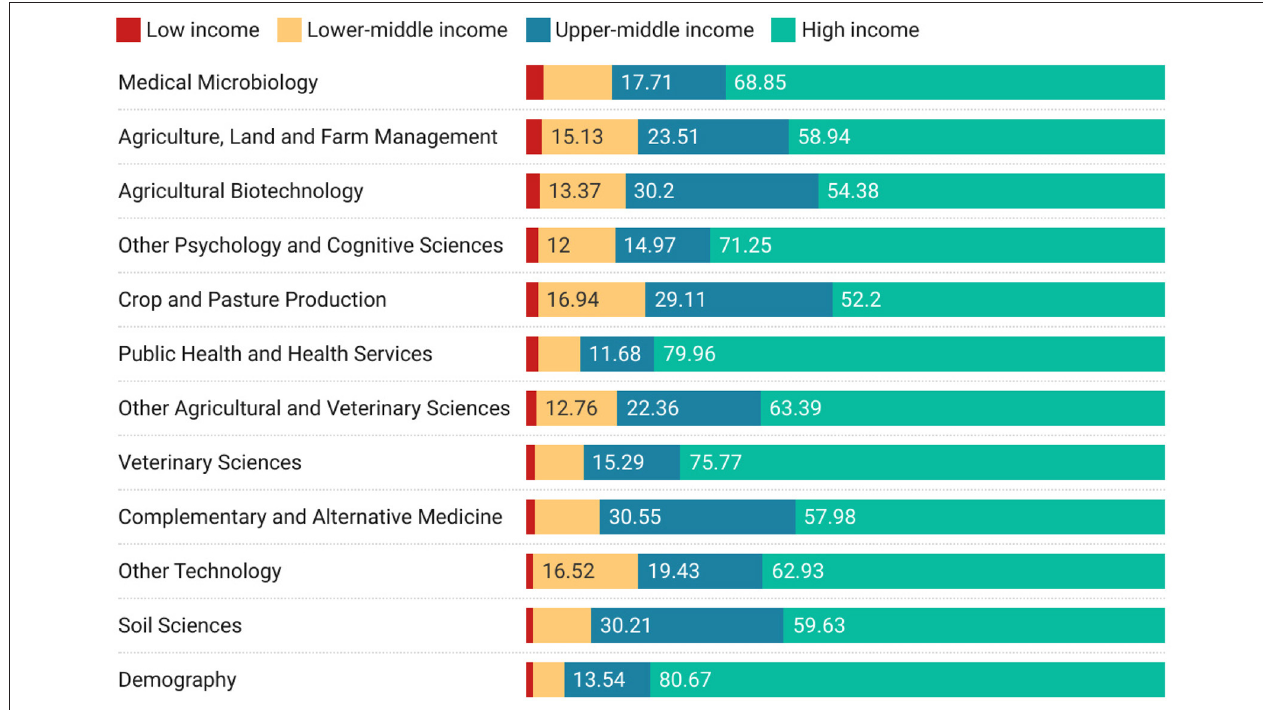
FIGURE 6 | Top 12 high-to-Low-income-country collaborations by field of research ordered by proportion of low-income country collaborations.